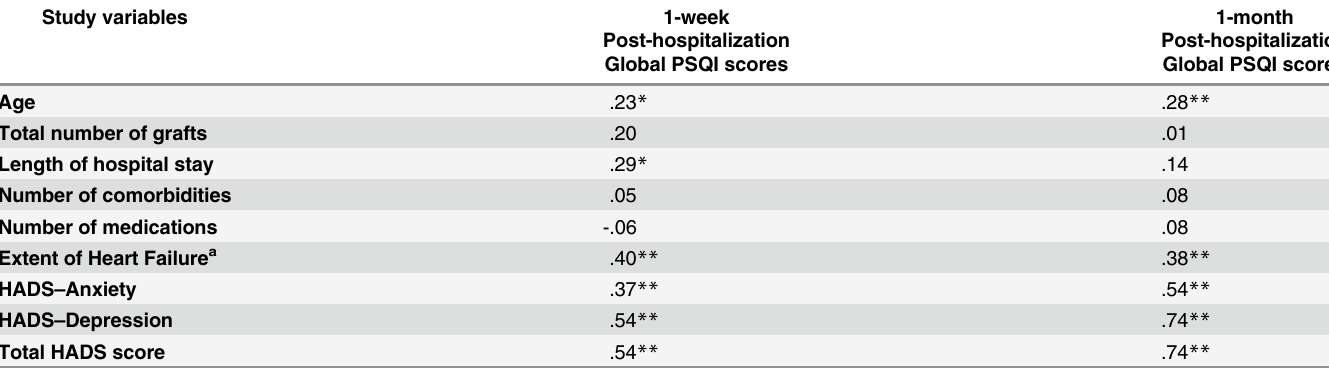
Table 5. Correlations between global PSQI scores and study variables at 1 week and 1 month post-hospitalization ( n =